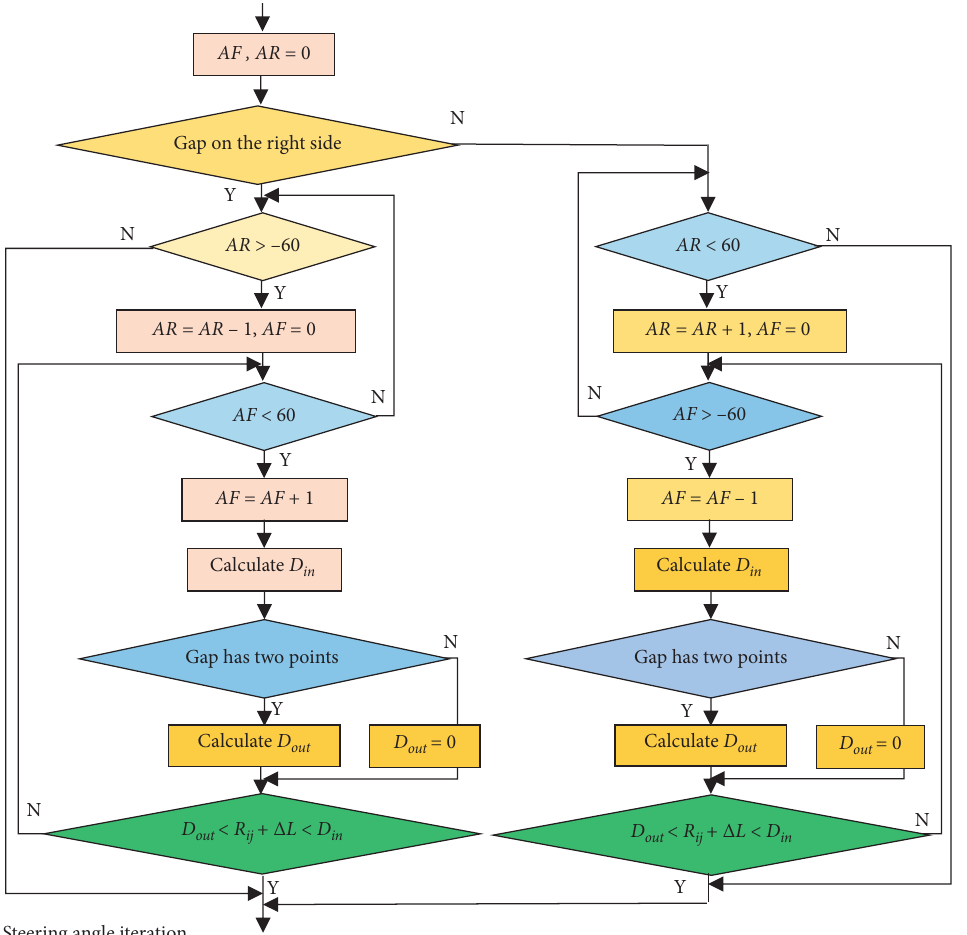
Figure 13: Two-level iterative